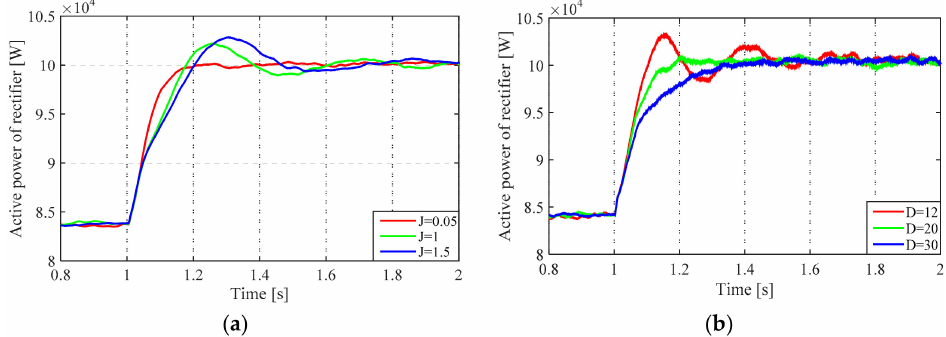
Figure 8. The influence of different inertia and damping on the active power of the rectifier ( a ) Different inertia J ; ( b ) Different damping D